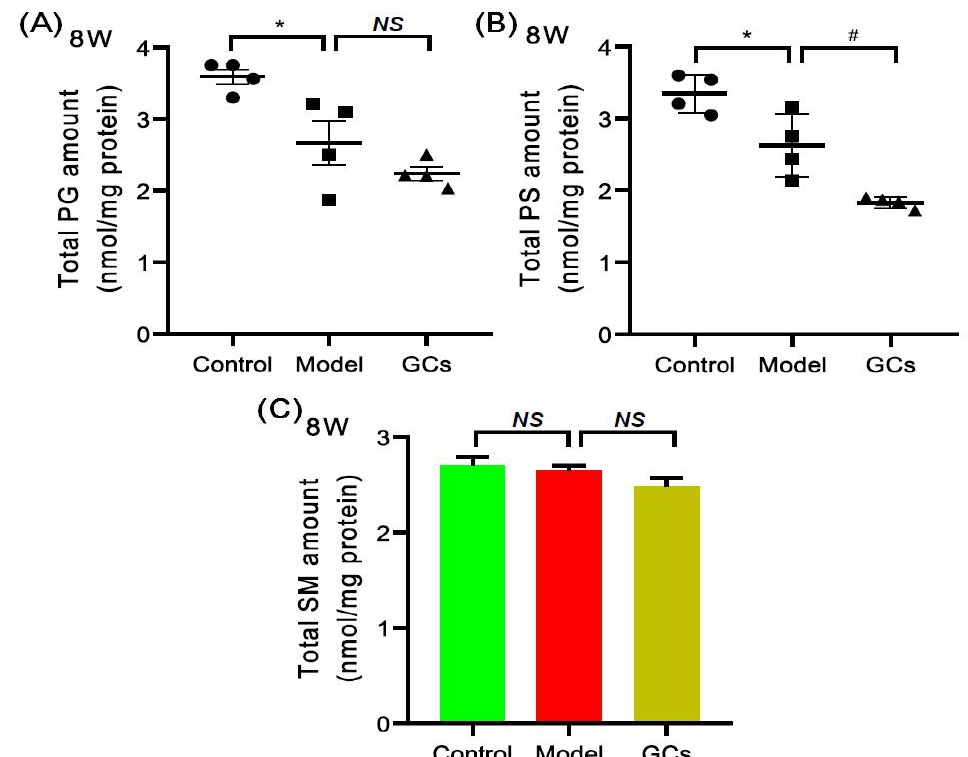
Figure 6. Comparison of the levels of other classes of phospholipids and sphingomyelin species in heart tissues from MRL/lpr mice from each group. Heart tissues of the control ( n = 4), model ( n = 4), and GCs ( n = 4) groups were collected at 8 weeks of age. Both model and GCs group were MRL/lpr mice, while the control group was MRL/MpJ mice. Lipidomics analysis of other classes of phospho- lipids, including phosphatidylglycerol (PG) and phosphatidylserine (PS) species (Panels A and B ) and sphingomyelin (SM) species (Panel C ) present in lipid extracts of heart was performed through multidimensional mass-spectrometry-based shotgun lipidomics. The data represent means ± SEM from different groups. Difference between the groups was determined using ANOVA followed by Dunn multiple comparison with IBM SPSS Statistics 19 Software (SPSS Inc., Chicago, IL, USA) after the normality of each group of variables was checked by Q–Q plots. The raw p values were adjusted to false discovery rat using the Benjamini–Hochberg method. * adjusted p < 0.05 and # adjusted p < 0.05 compared with those in the control group and the model group, respectively. NS , not significant.